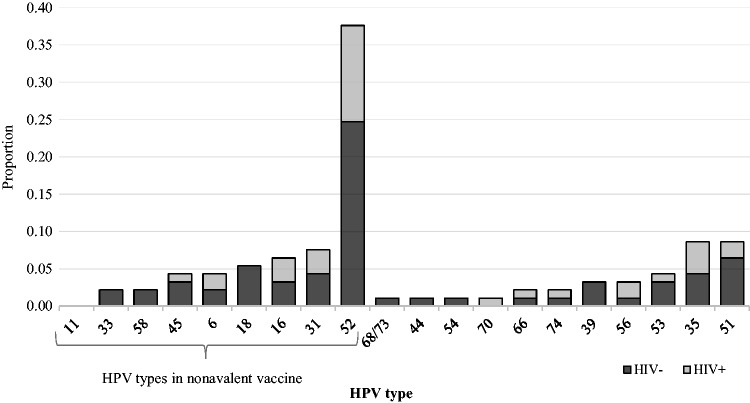
Baseline distribution of HPV types in a cohort of 348 FSWs in Nairobi, Kenya. HPV: human papillomavirus.